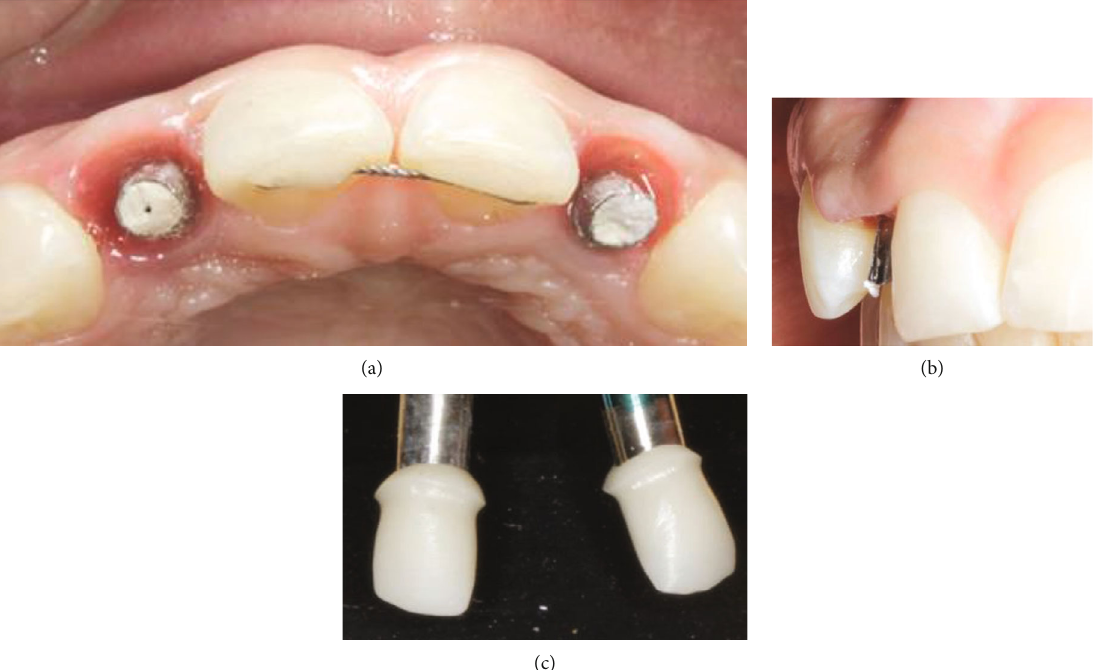
Figure 5: (a) Occlusal view of the peri-implant mucosa 2 months after interim restoration placement. (b) Lateral view showing that the keratinized gingiva adapted and conformed to the prosthetic emergence pro fi le of the interim restoration in a specular way. (c) The de fi nitive restoration frameworks with the reinforced collars that allowed a thick layer of ceramic at the margin of the